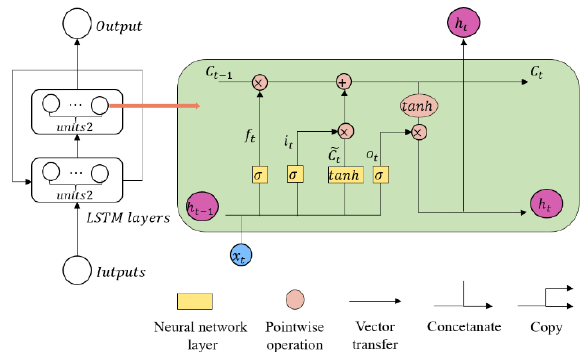
Figure 3. The illustration of two-layers LSTM model. 𝑥 and ℎ are the inputs and outputs at 𝑡 𝑡 time t